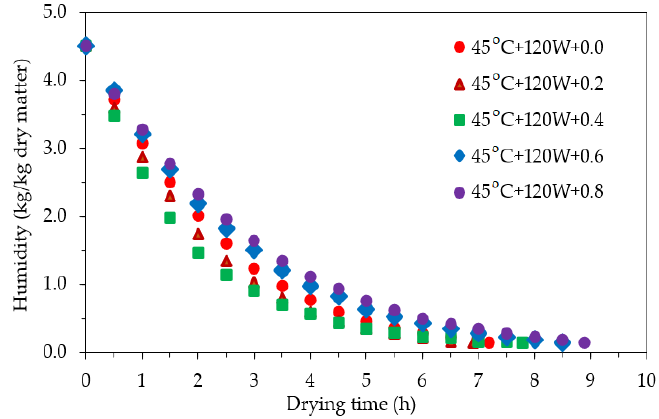
Figure 9. Drying curves at 45°C with different intermittency ratios.